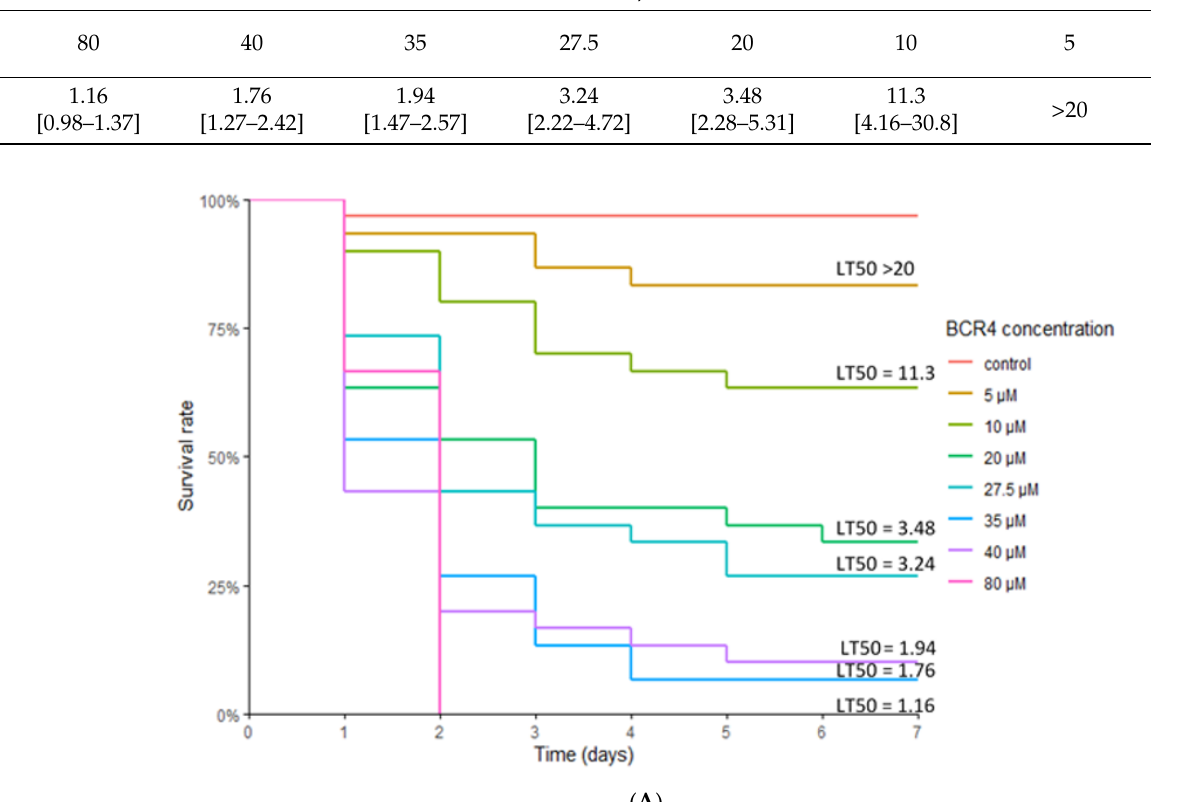
Table 1. Antimicrobial activities of BCR4 peptide.